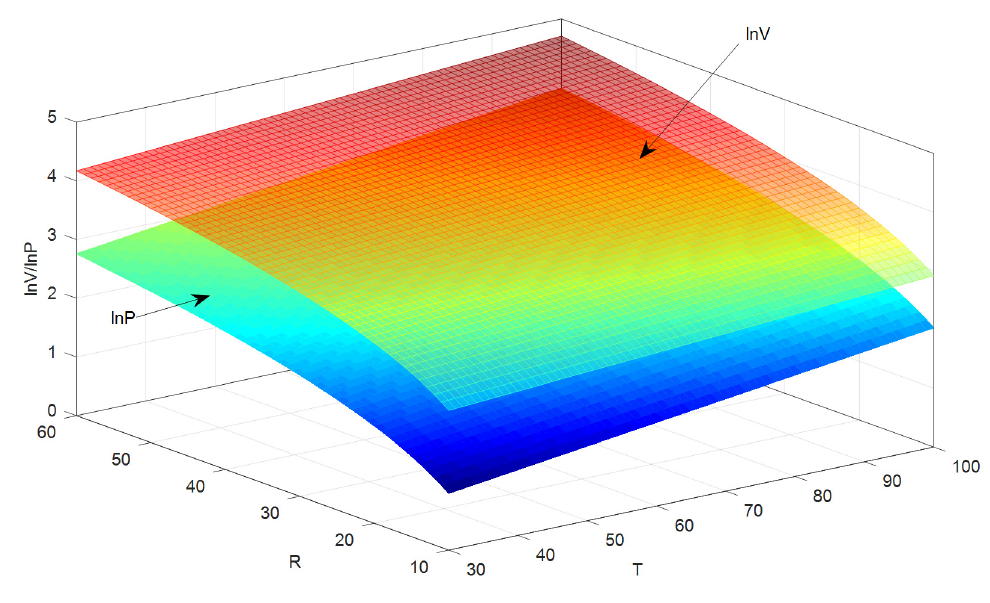
Figure 9. Output power at different temperatures. ( a ) At 20 °C; ( b ) At temperature gradient.